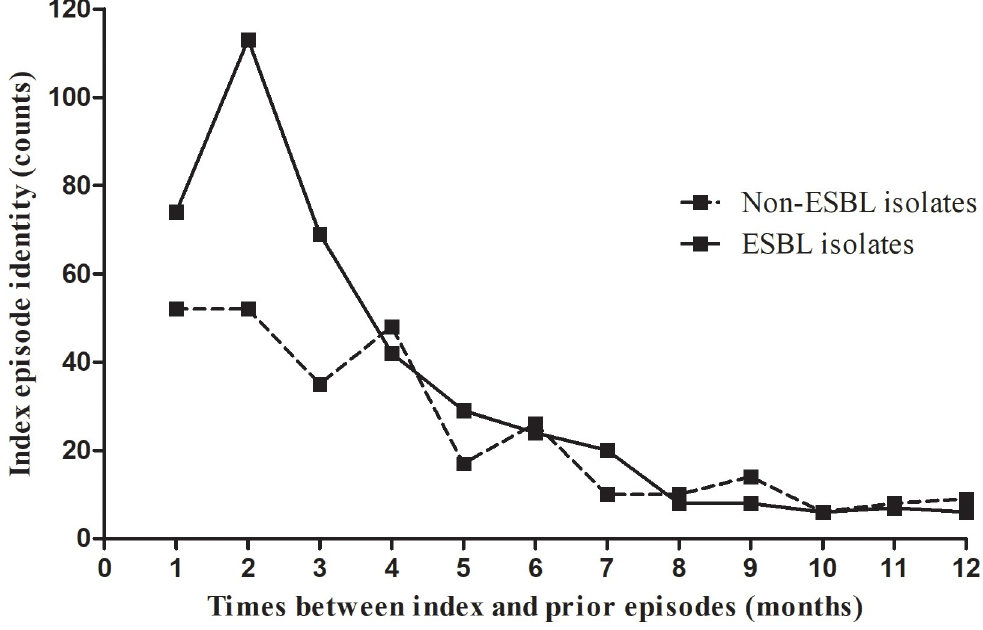
Fig 2. Relationship between monthly interval and index episode